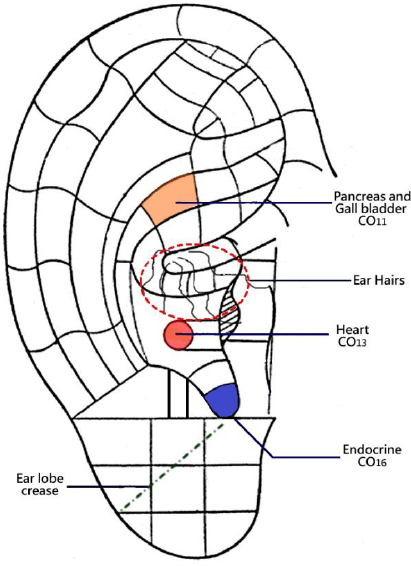
Figure 1. Auricular points and signals for testing the association of metabolic syndrome.